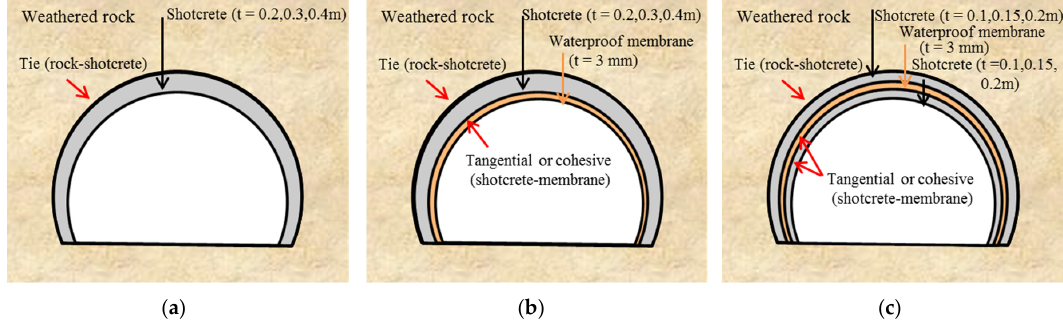
Figure 14. Setups for the stability analysis of tunnel linings. ( a ) Case 1: Shotcrete lining on a rock. ( b ) Case 2: Waterproof membrane attached to the bottom of shotcrete, and ( c ) Case 3: Membrane inside the shotcrete.